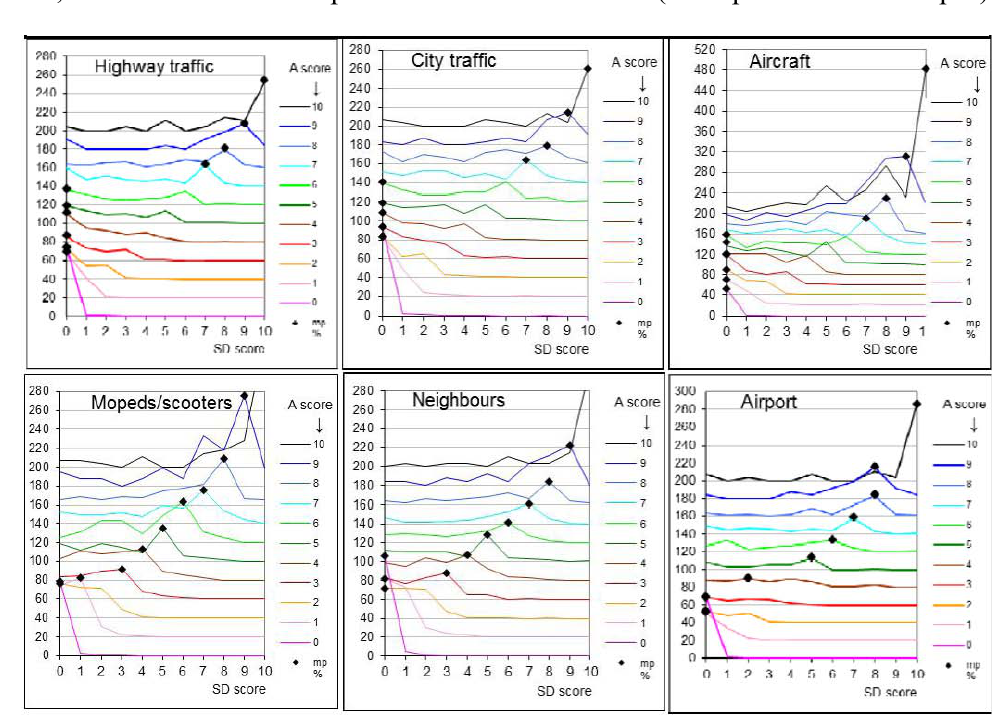
Figure 4. distribution of Sleep Disturbance scores score given by respondents that report